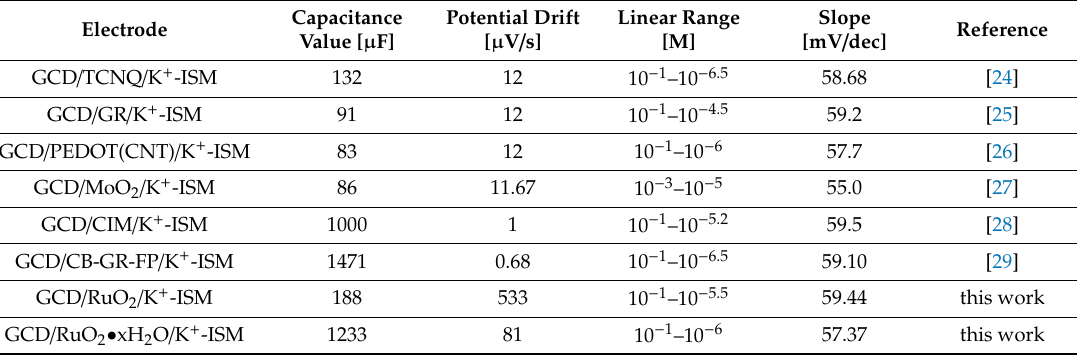
Table4. ElectricalandpotentiometricparameterscomparedforGCD / SC / K +